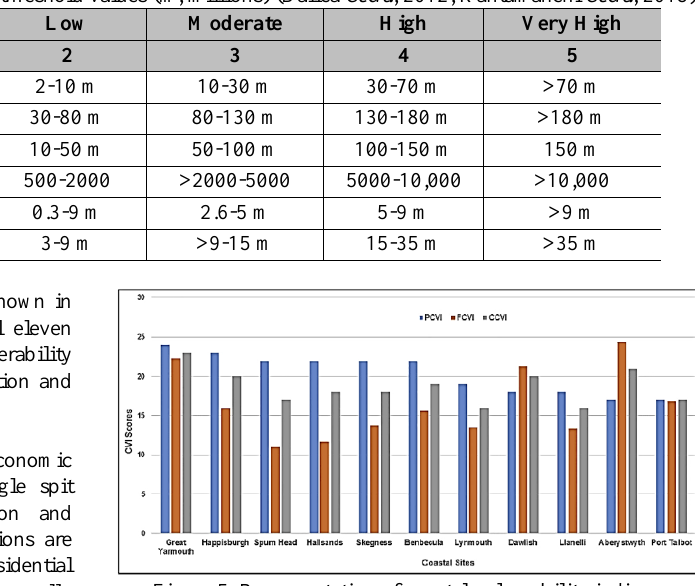
Figure 5. Representation of coastal vulnerability